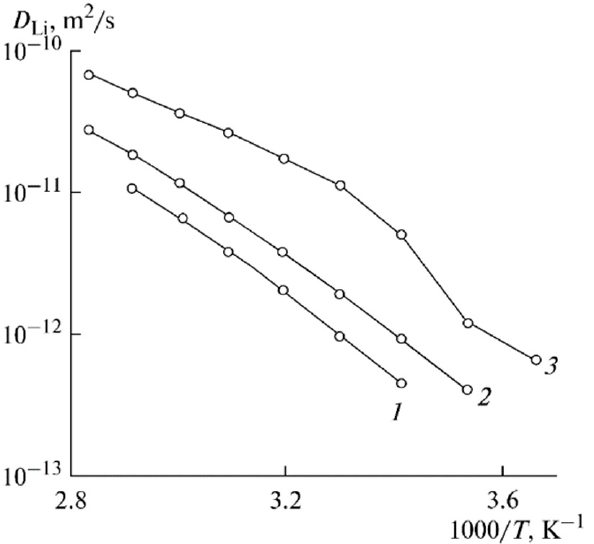
Figure 14. Temperature dependences of the Li + self-diffusion coefficients for PGE no. ( 1 ) 2, ( 2 ) 5, and ( 3 ) 8 [53].